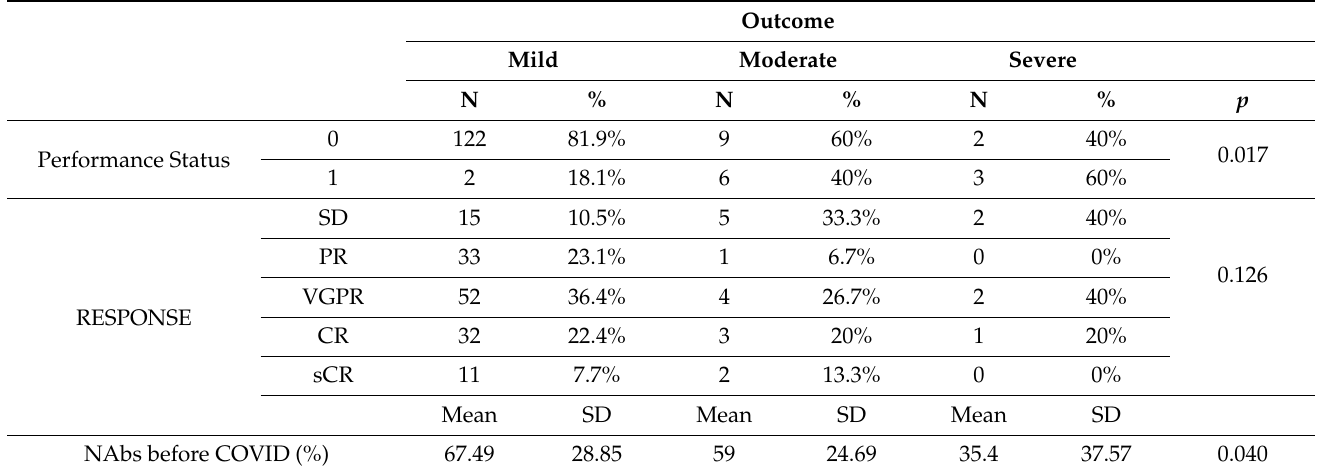
Table 7. Differences in COVID-19 outcomes depending on performance status, response to treatment for MM, and NAbs before SARS-CoV-2 infection (SD: stable disease, PR: partial response, VGPR: very good partial response, CR: complete response, sCR: stringent complete response).